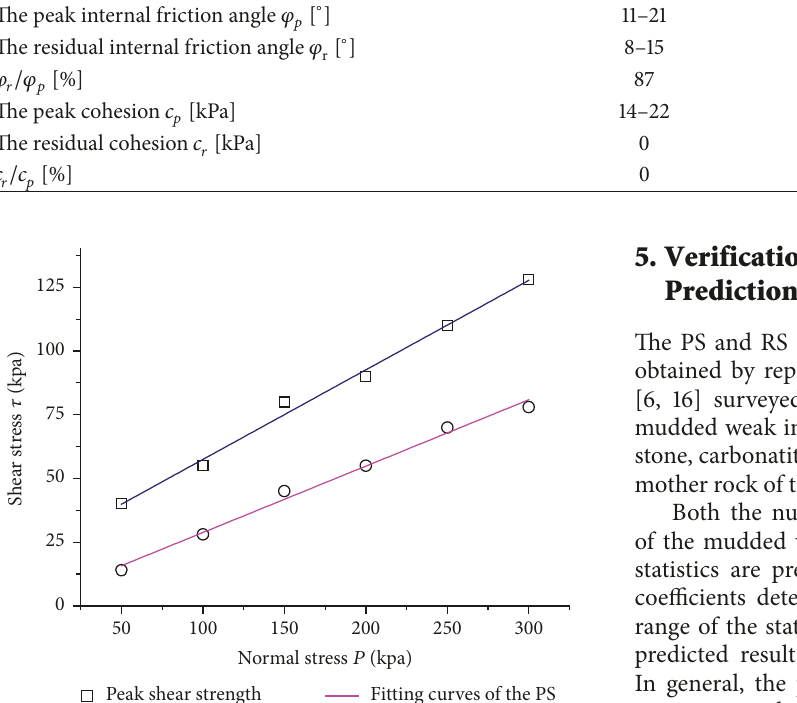
Table 4: Numerically predicted shear strength of the mudded weak interlayer and the values obtained by statistics. PS and RS